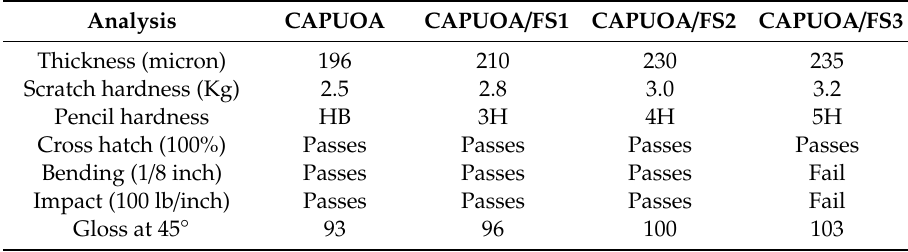
Table 2. Physico-mechanical performance of CAPUOA and CAPUOA / FS